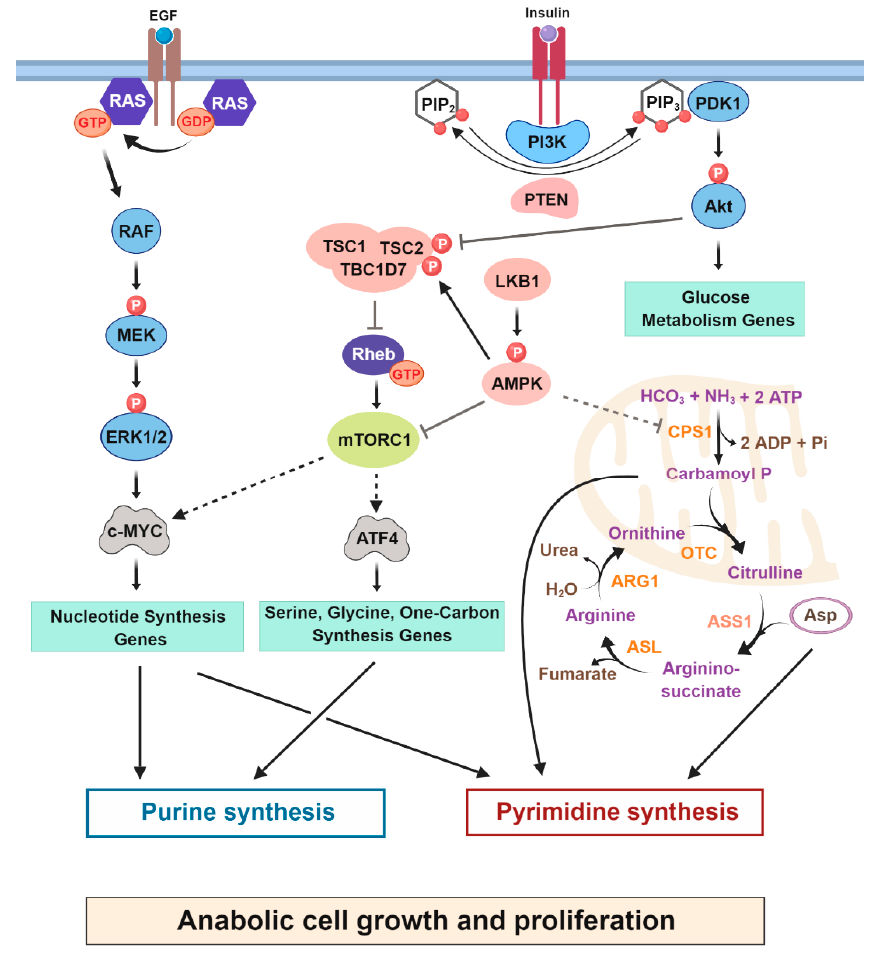
Figure 3. Slow regulation of nucleotide synthesis by oncogenes and tumor suppressors. Growth factor and oncogenic signaling reprogram nucleotide metabolism to increase the biomass essential for cell proliferation. Signaling downstream from PI3K/Akt enhances glucose uptake and glycolysis. The MYC transcription factor, activated downstream from RAS, enhances de novo purine and pyrimidine synthesis. In addition to MYC activation, mTORC1 increases the levels of ATF4 stimulating synthesis of serine, glycine and one carbon formyl units contributing to purine synthesis. Loss of LKB1 and oncogenic activation of K-RAS lead to an increase in CPS1, a key urea cycle enzyme that produces carbamoyl phosphate intermediate supplying de novo pyrimidine synthesis. Tumor suppressors are shown in pink, and key oncogenic signaling kinases in light blue. Metabolic enzymes are shown in orange and small GTPases in dark blue. CPS1- Carbamoyl phosphate synthetase 1, OTC—Ornithine